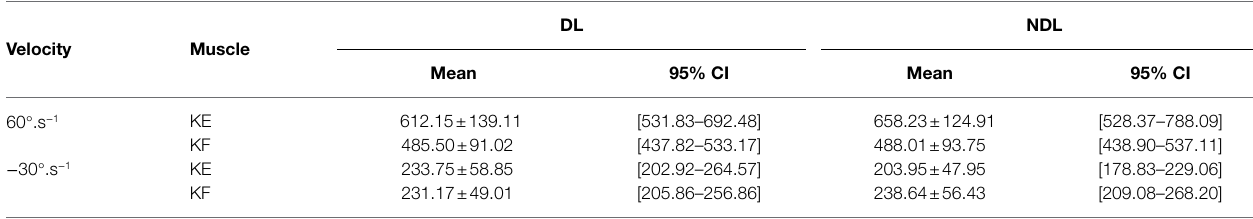
TABLE 2 | Rate of torque development (RTD in N.m.s − 1 ) of knee extensor (KE) and knee flexor (KF) in dominant leg (DL) and non-dominant